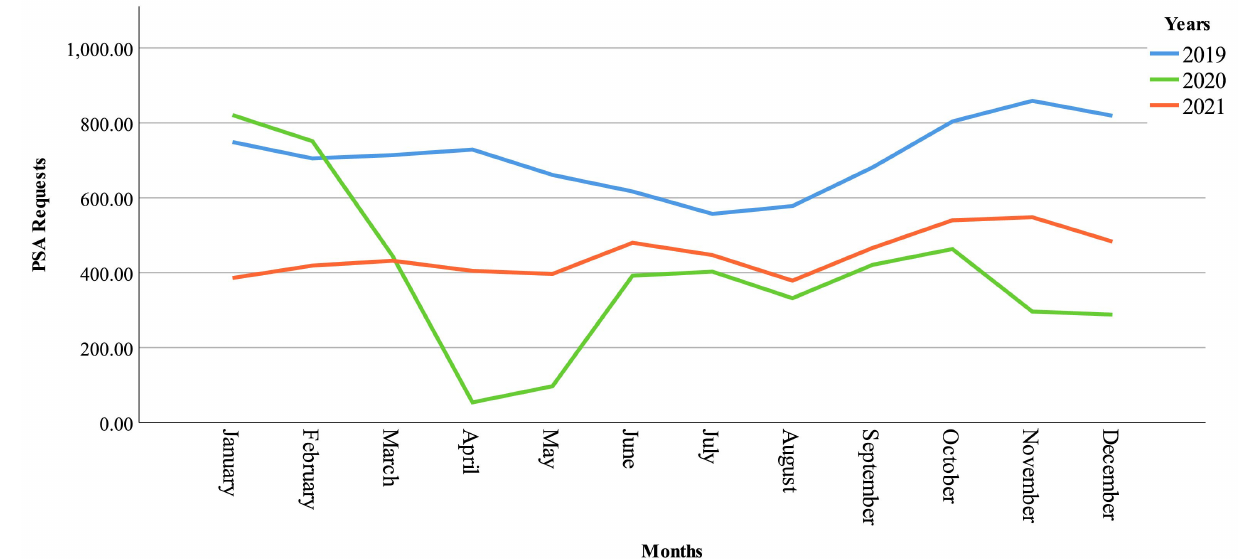
Fig. 1. Prostate specific antigen (PSA) requests s in the pre-pandemic and pandemic periods. Table 1. Characteristics of the study population who underwent TRUS guided prostate biopsy (n = 141). Variables